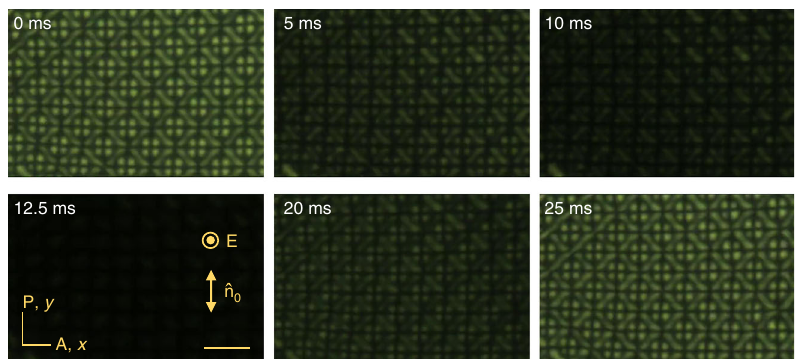
Fig. 5 Polarizing microscopy textures of oscillating patterns. The patterns cover the entire electrode area of the cell and appear at voltages higher than the range of stability of isolated solitons. The images are taken at the moments of time indicated on the textures, within a 25 ms time interval that corresponds to the half period of the applied voltage (14.7 V, 20 Hz). Scale bar 20 µ m